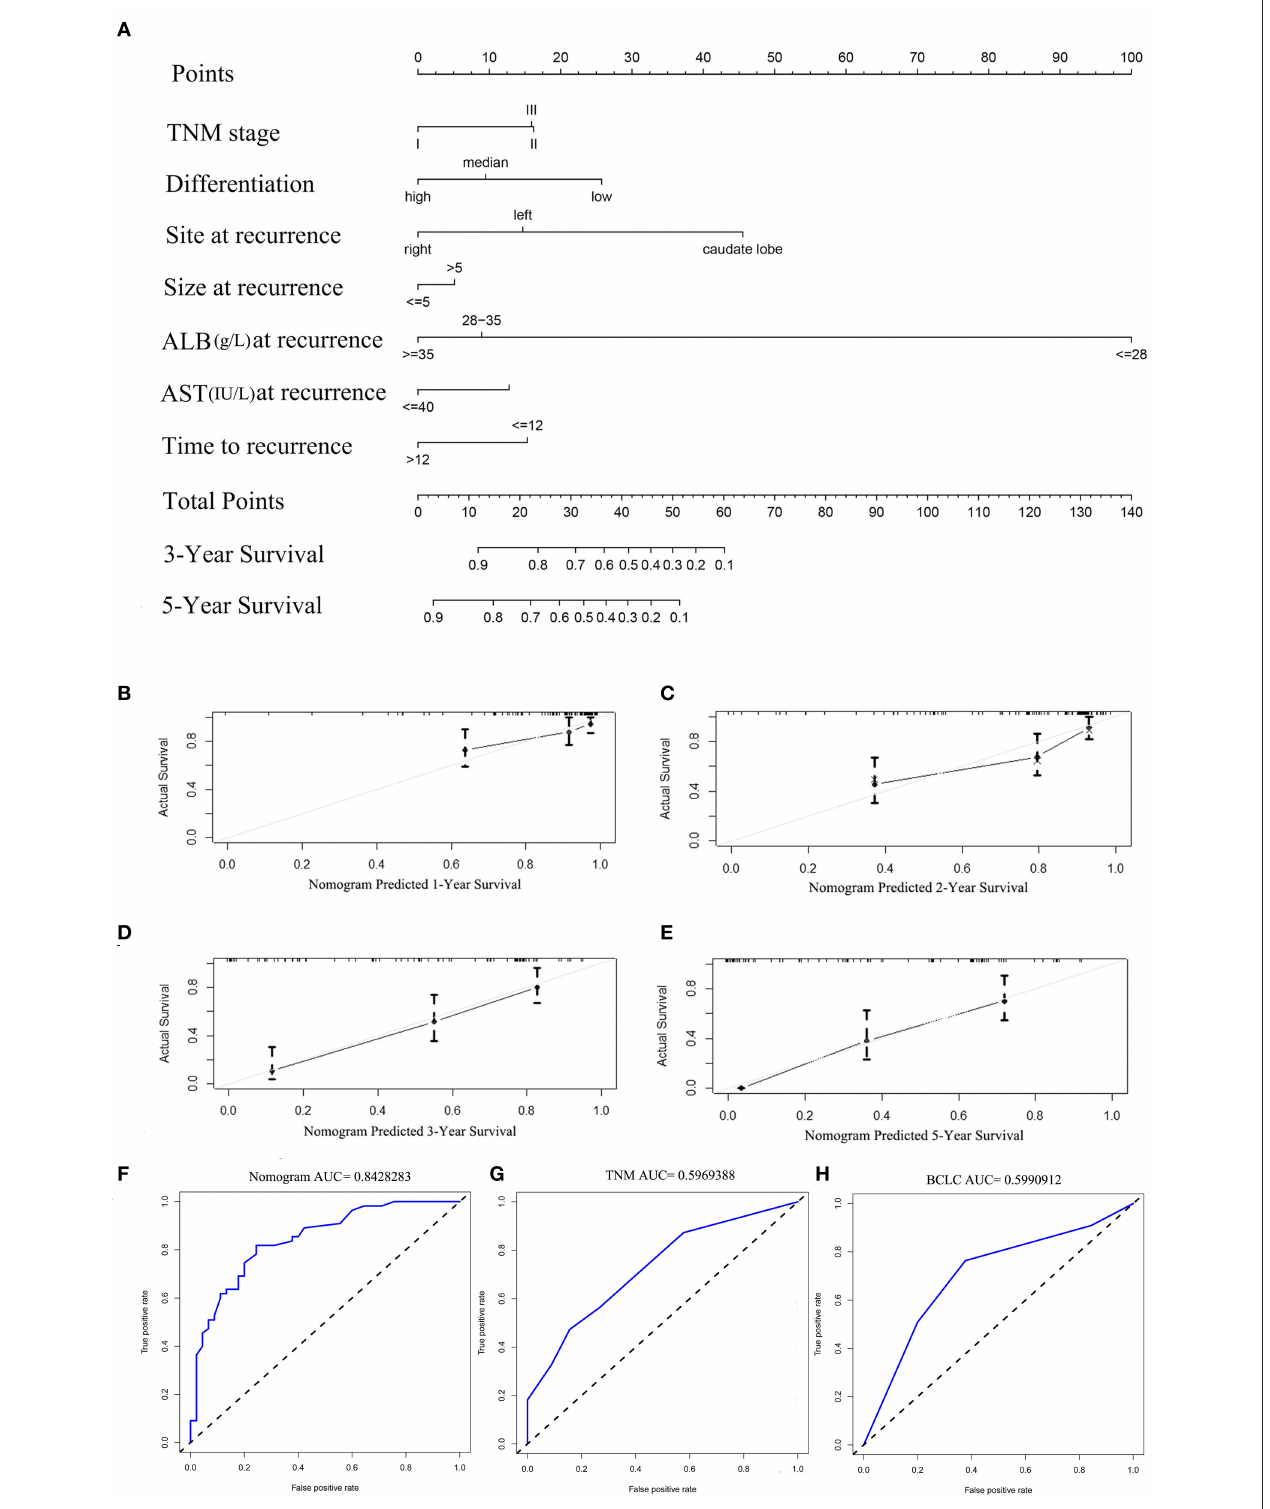
FIGURE 2 | (A) Nomogram for predicting the 3- and 5-year post-recurrence survival rates in patients with repeat hepatectomy (RH) of hepatocellular carcinoma (HCC). The calibration curve for predicting the 1-, 2-, 3-, and 5- year post-recurrence survival in the training (B–E) cohort; nomogram-predicted probability of PRS is plotted on the x-axis; actual PRS is plotted on the y-axis. The area under the curve (AUC) of the nomogram, and the tumor, node, and metastasis (TNM) and BCLC stage systems in the training cohort (F–H) .